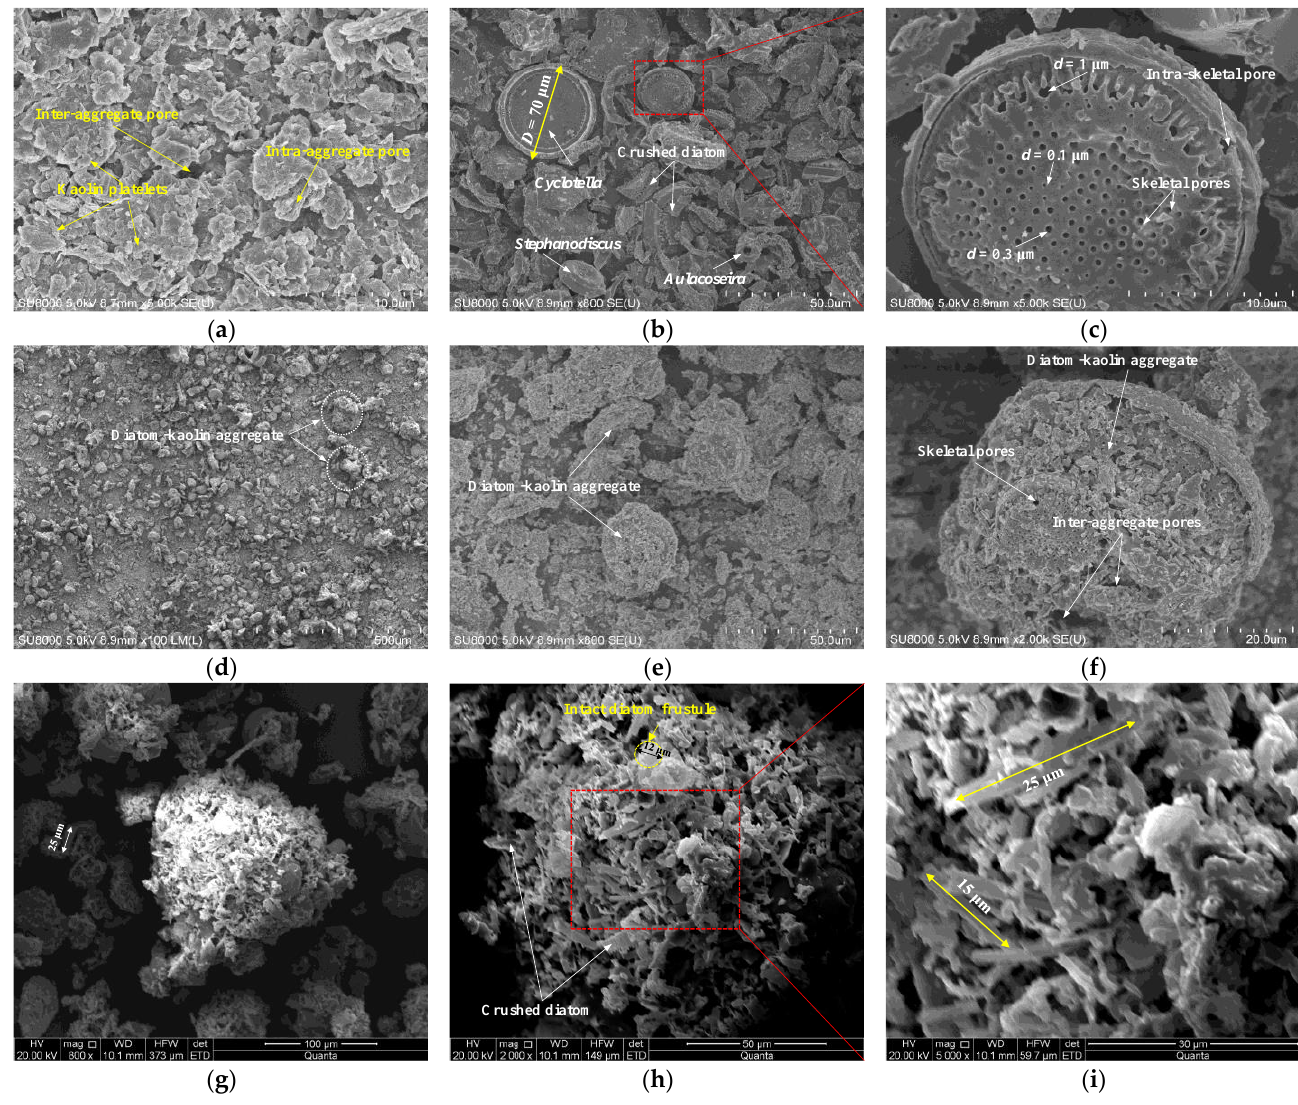
Figure 3. Scanning electron microscopy images of ( a ) kaolin (0D-100K) ( b , c ) diatoms (100D-0K), ( d – f ) a DKM (60D-40K), and ( g – i ) crushed diatoms.